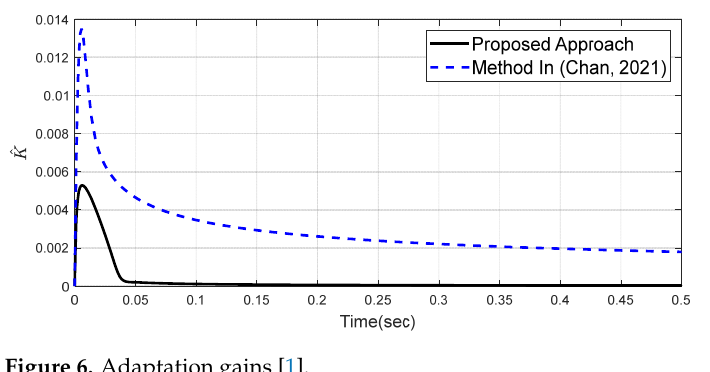
Figure 6. Adaptation gains [1] . Table 1. Comparing the responses of the DBC system under the conditions of scenario